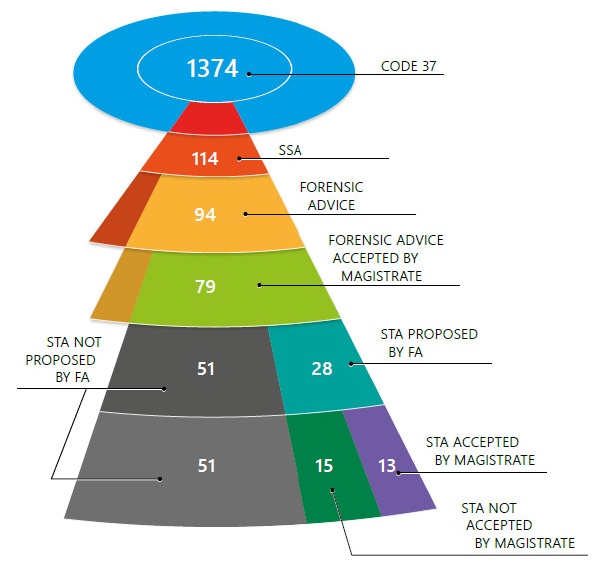
Figure 4. Case selection flow. The number of cases are indicated; SSA: samples after sexual aggression; STA: systematic toxicological analysis.